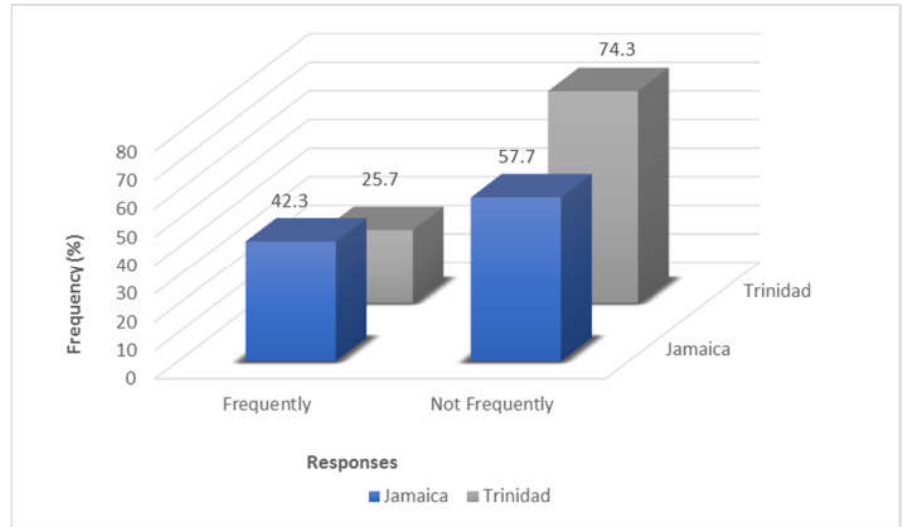
Figure 2. Comparison of how often combination therapy is utilized in Jamaica vs. Trinidad.